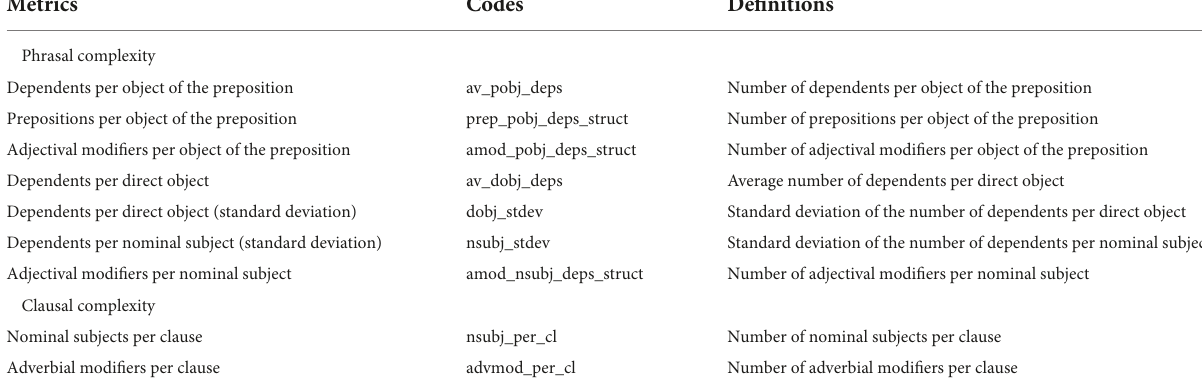
TABLE 3 The nine fine-grained complexity metrics from